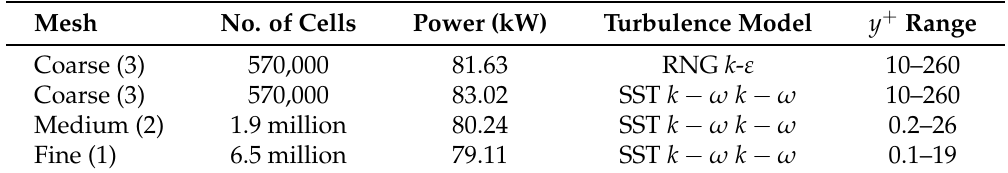
Table 4. Grid convergence study for a flow passage around a blade using different turbulence models and numbers of